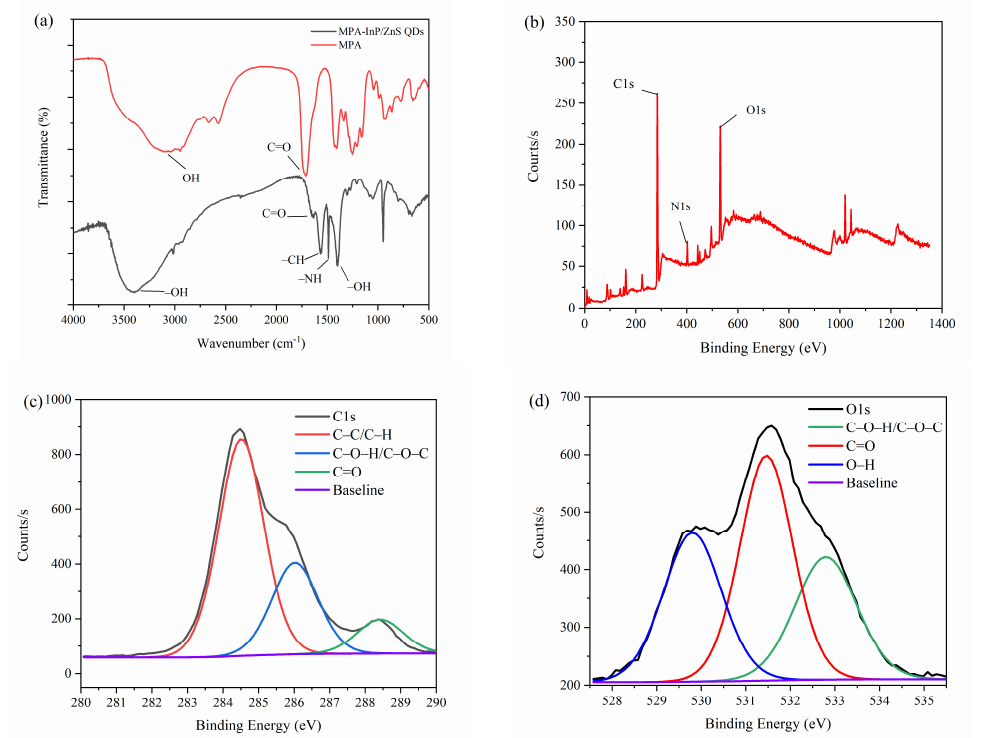
Figure 2. FT-IR spectrum ( a ), XPS patterns ( b ), C1s XPS spectrum ( c ), and O1s XPS spectrum ( d ) of MPA-InP/ZnS QDs. XPS: X-ray photoelectron spectroscopy, C1s XPS: X-ray photoelectron spectroscopy of 1s orbital electron peak of carbon atom, O1s XPS: X-ray photoelectron spectroscopy of 1s orbital electron peak of oxygen atom, MPA-InP/ZnS QDs : mercaptopropionic acid capped InP/ZnS quantum dots.